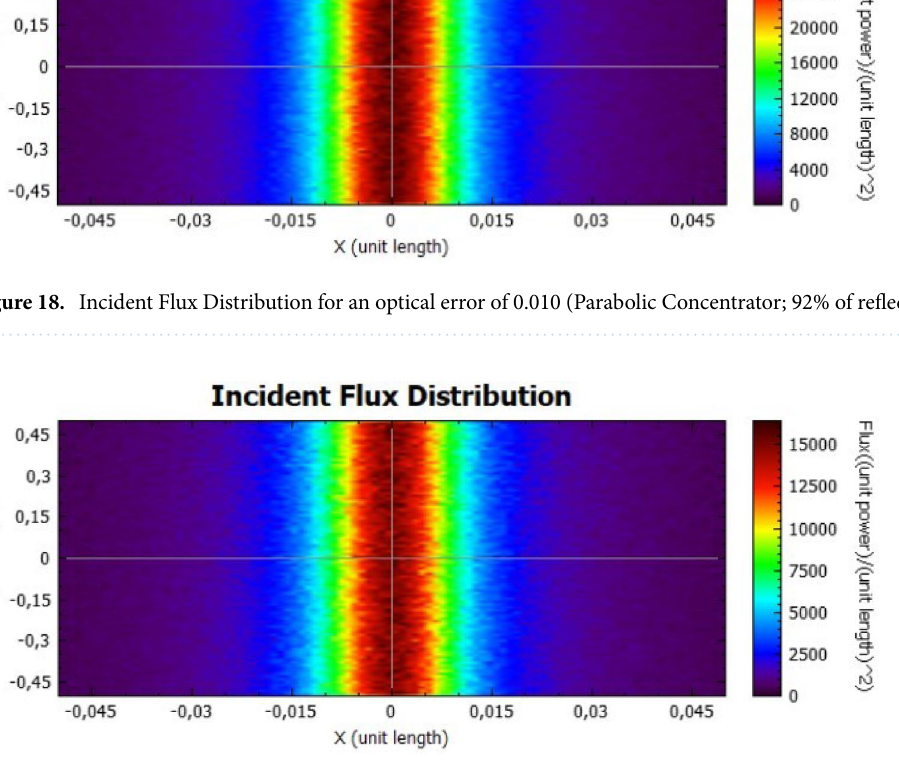
Figure 19. Incident Flux Distribution for an optical error of 0.010 (Parabolic Concentrator; 47% of